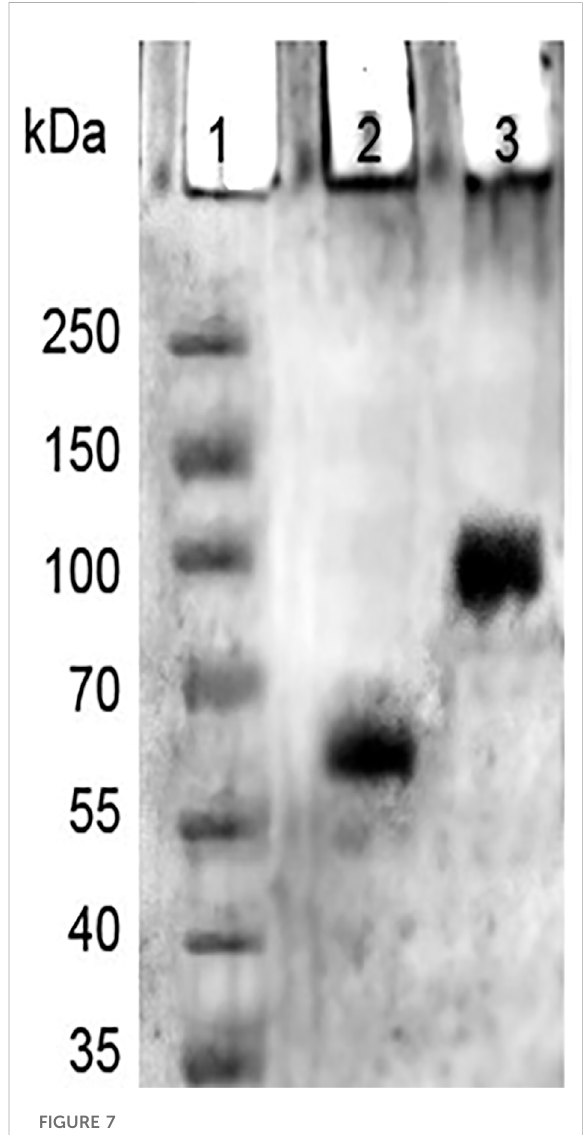
FIGURE 7 SDS-PAGEofmarkers(Lane1),native HSA(Lane2),and,4-Cl- OPD modi fi ed HSA (Lane 3).